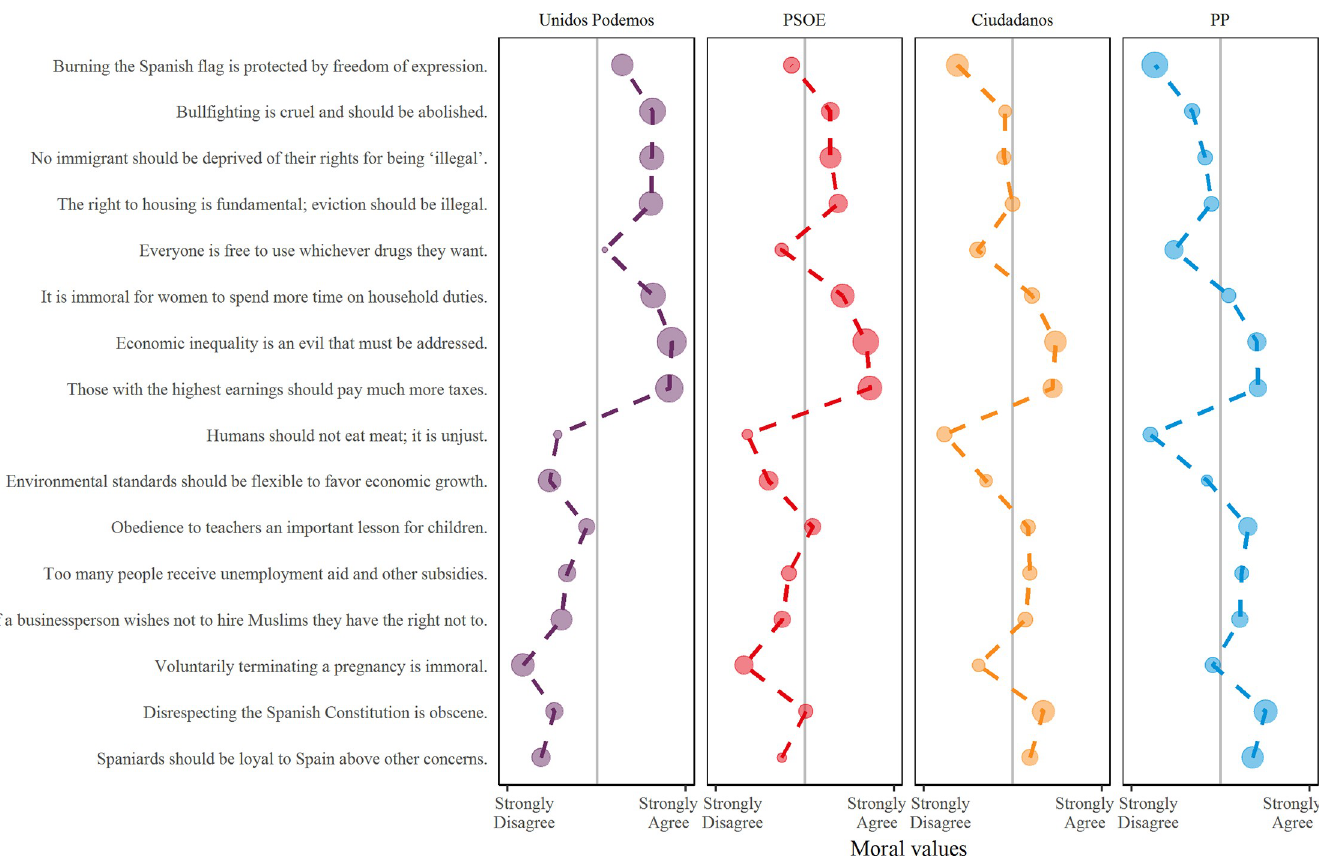
Fig 2. Agreement with each statement by preferred party. Large points represent objective issues, while small points represent relativist